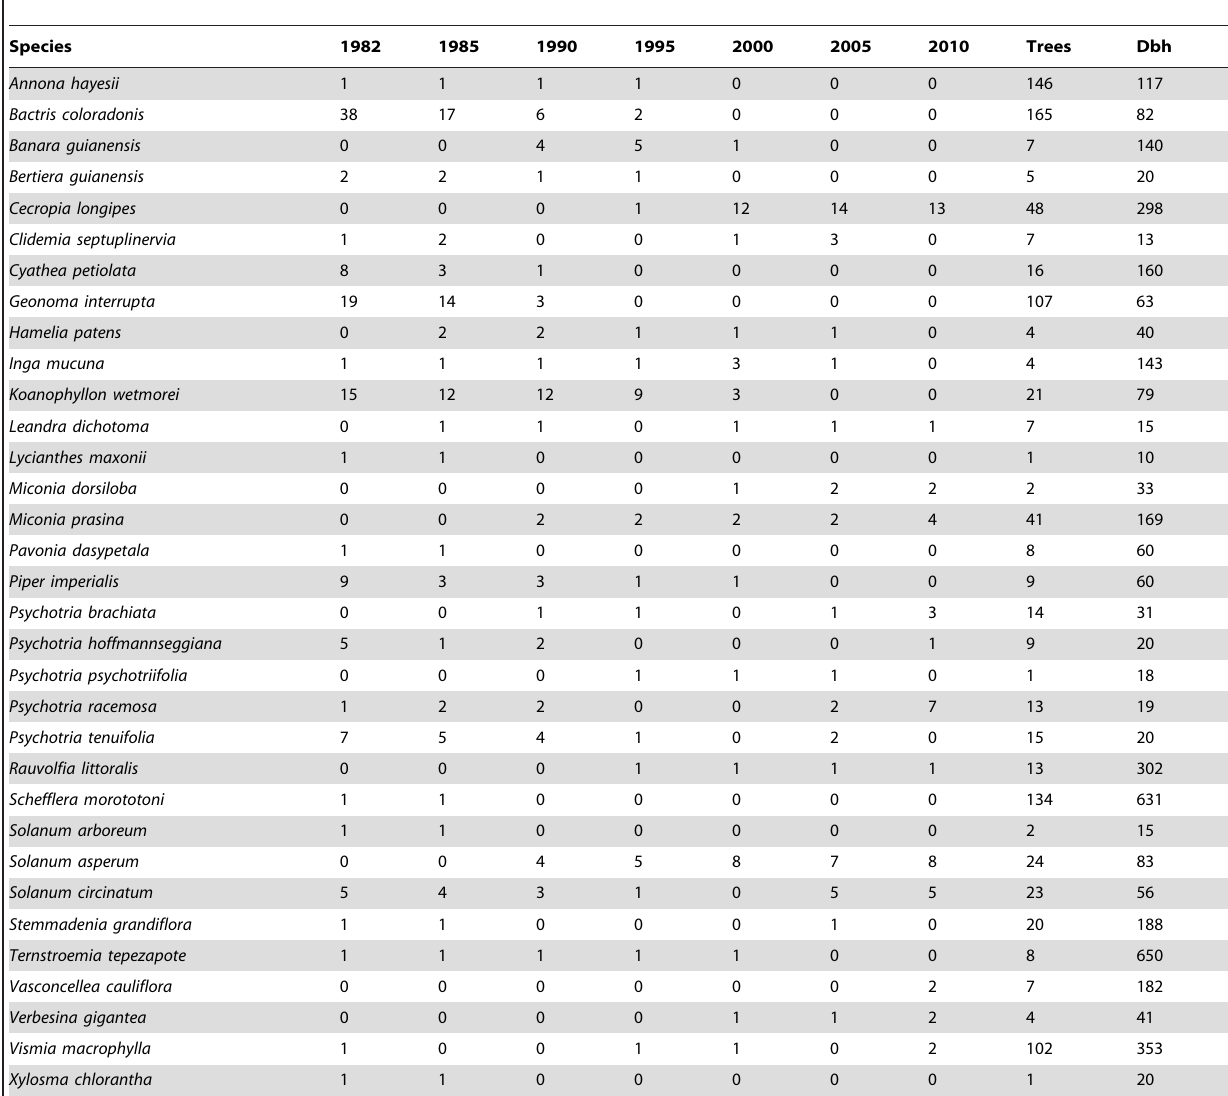
Table 2. Abundance (number of individuals § 10 mm stem diameter) in each of the seven censuses, 1982–2010, of the 33 species in the Barro Colorado 50-ha plot that were absent in at least one census, of the total of 308 species observed in the plot.